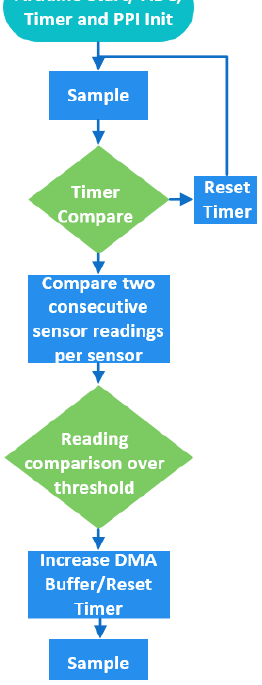
Figure 7. Sampling